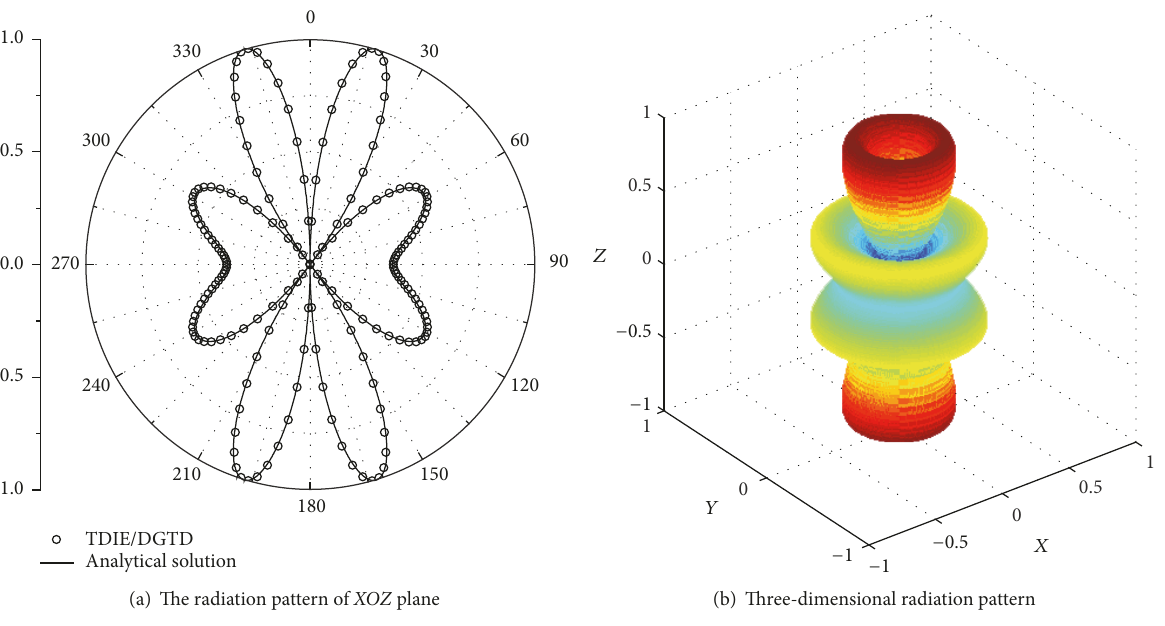
Figure 4: The radiation pattern of a circular antenna.